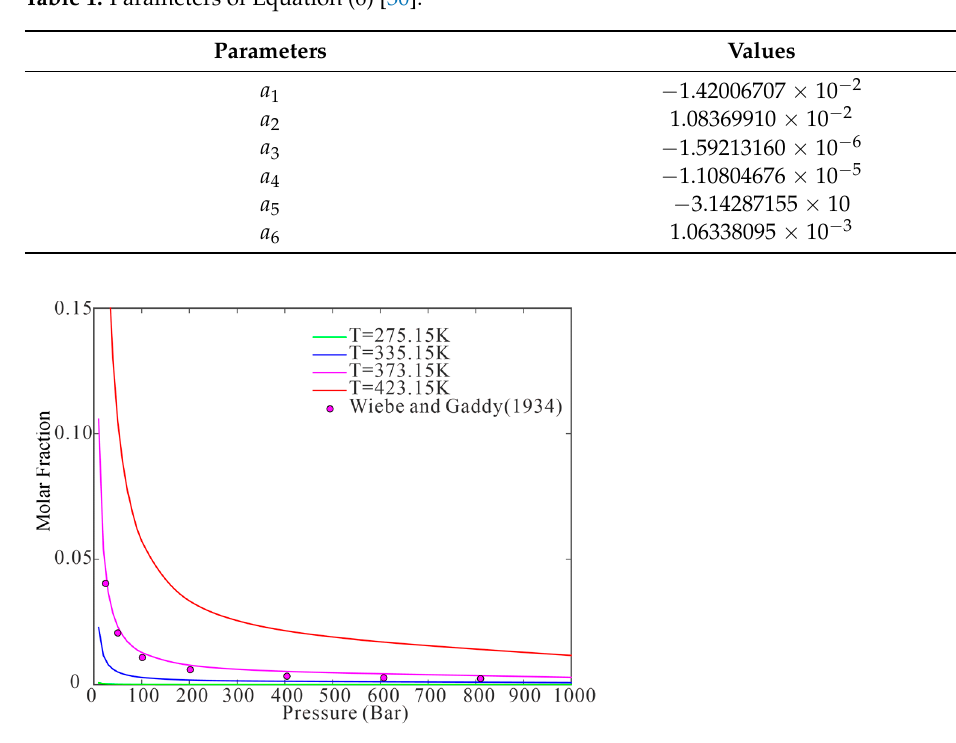
Figure 1. Pressure ‐ dependent water content in the vapor phase as predicted using the model (The Figure 1. Pressure-dependent water content in the vapor phase as predicted using the model (The point reported by Wiebe and Gaddy[20]; The curves calculated using the proposed model). point reported by Wiebe and Gaddy [20]; The curves calculated using the proposed ln  H 2